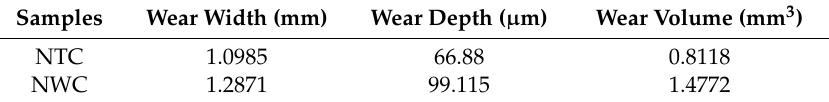
Figure 9. Wear profiles of NTC and NWC coatings. Table 3. Sliding wear results for the coatings.